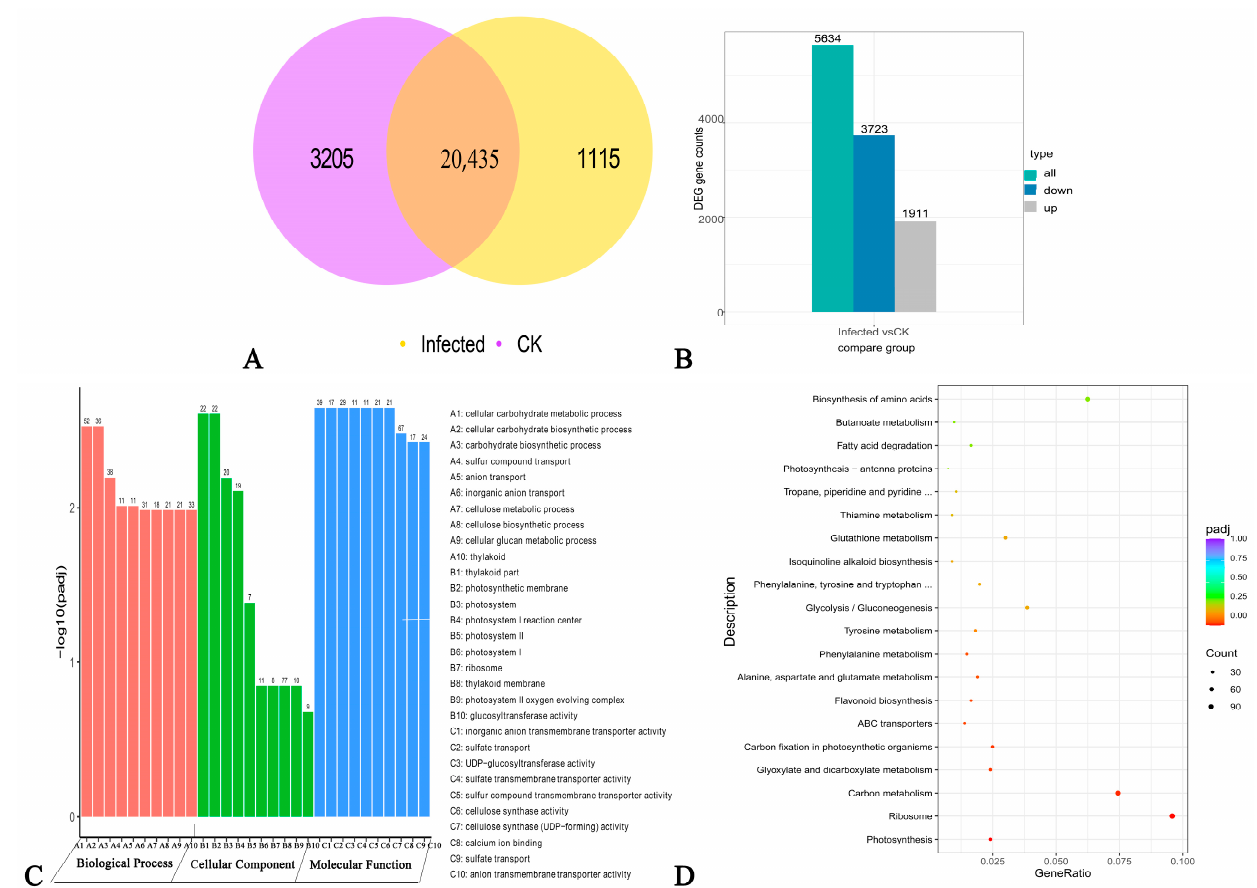
Figure 2. Results of differentially expressed gene analysis. Note: ( A ) DEG Venn diagram; ( B ) DEG volcano map; ( C ) GO enrichment analysis histogram; and ( D ) KEGG enrichment scatter plot.